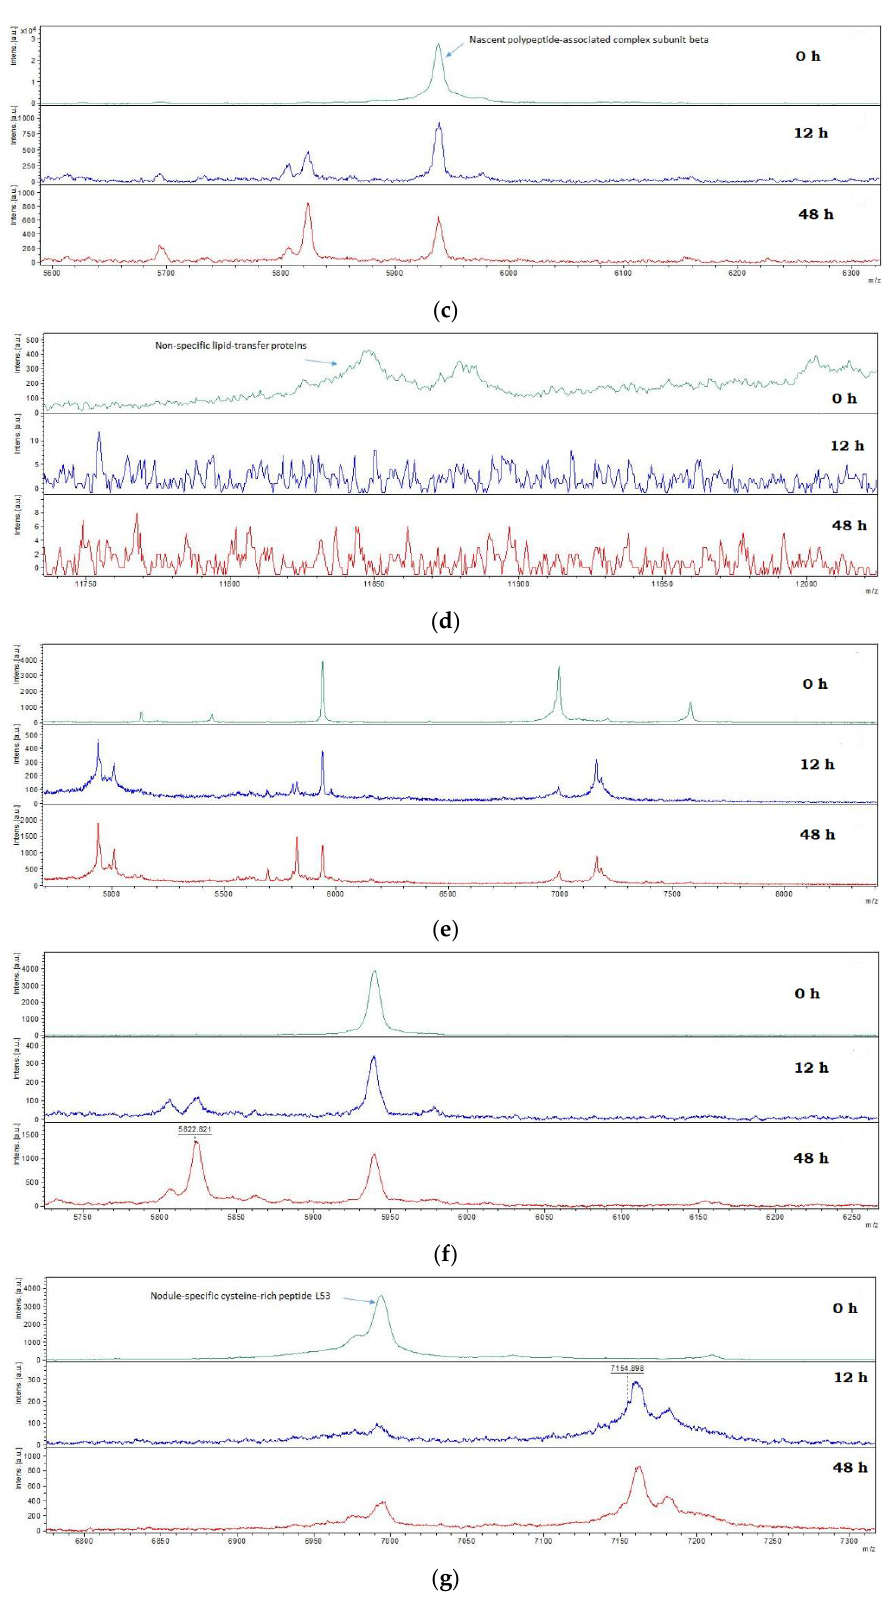
Figure 2. Comparison of the peptide fractions of Lens culinaris material through the analysis of selected MALDI TOF spectra with the LP1 ( a – d ) and LP2 ( e – g )